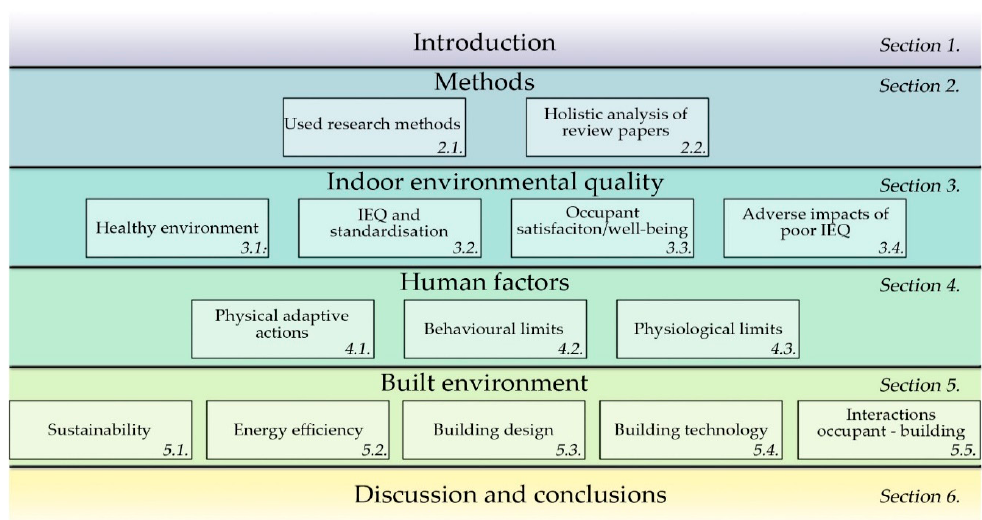
Figure 1. Connections between three levels (Building-Indoor environmental factors (IEQ)-Occupant) of a healthy and energy efficient building concept.